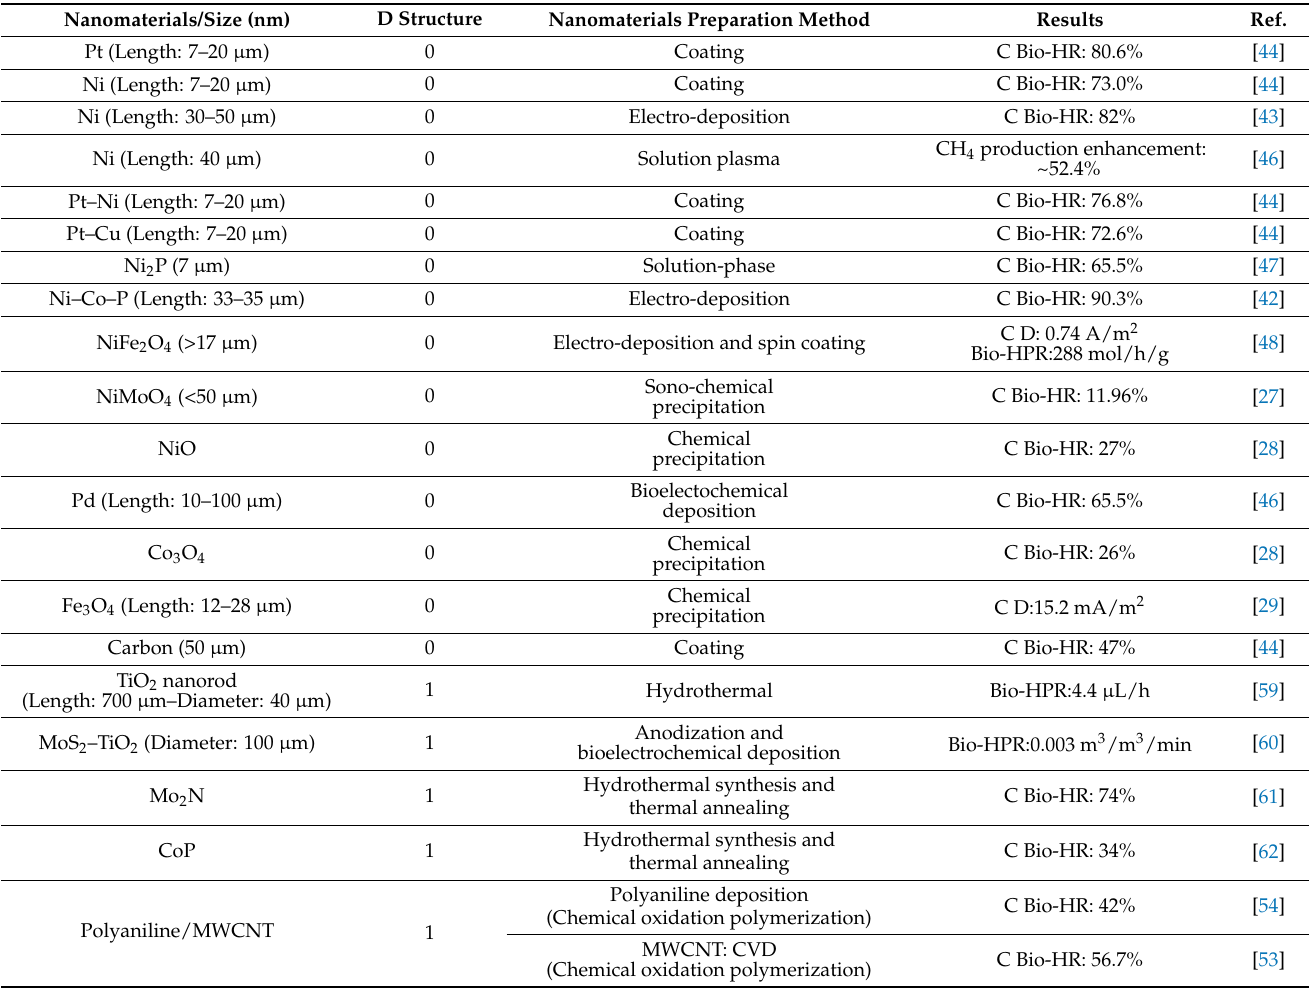
Table 2. Nanomaterials employed for cathodic catalysts and cathodic photocatalyst in MECs. Nanomaterials/Size (nm) D Structure Nanomaterials Preparation Method